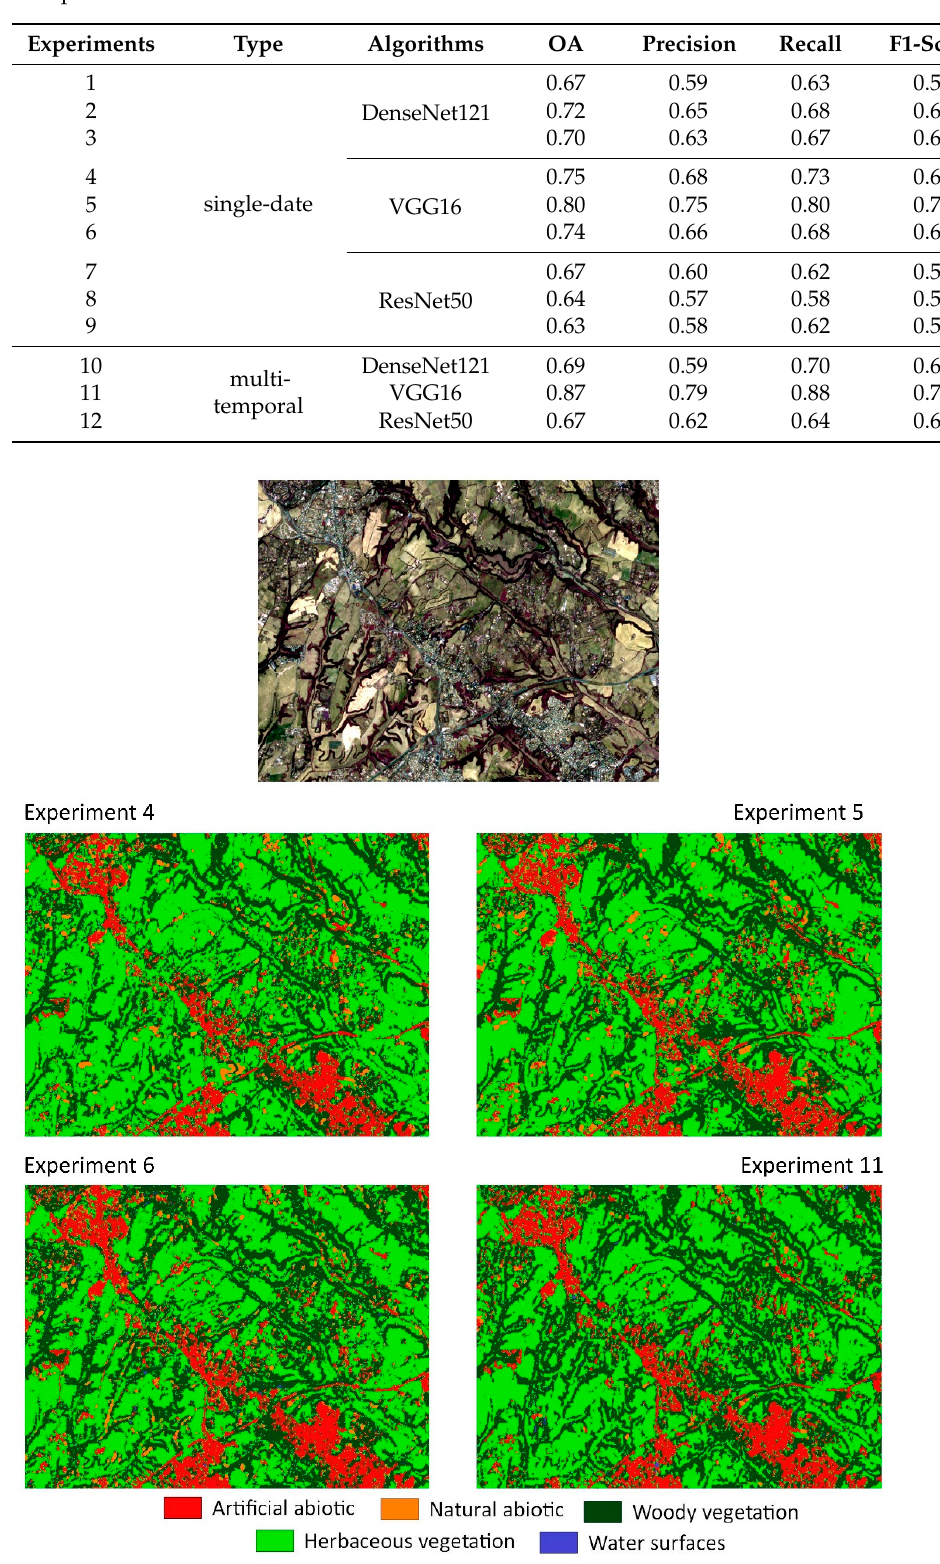
Figure 5. Land cover maps produced in the validation phase using the VGG16 algorithm with respect to spring (Experiment 4), summer (Experiment 5) and autumn (Experiment 6) images and to the multitemporal stack (Experiment 11).